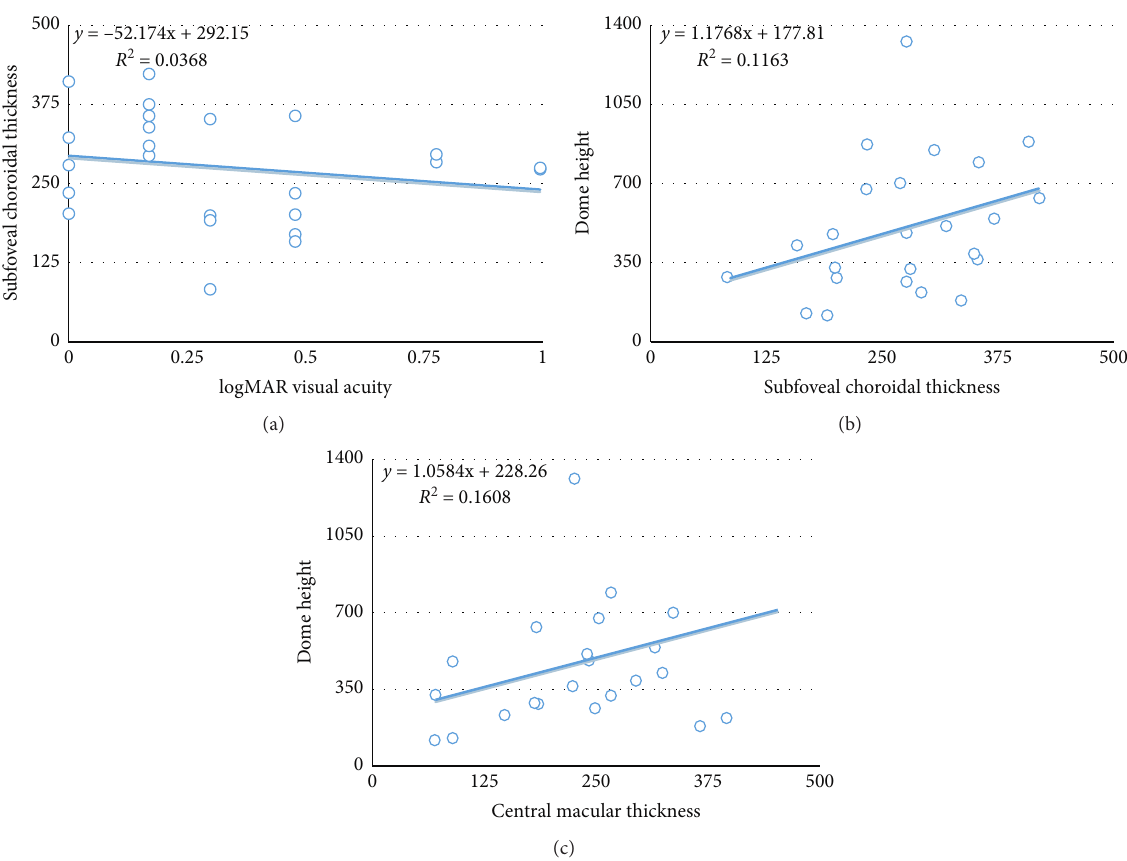
Figure 2: (a) Visual acuity (logMAR) showing a negative trend with subfoveal choroidal thickness ( ρ � 0.307). (b)-(c) Dome height showing a positive trend with SFCT ( ρ � 0.366) and CMT ( ρ �